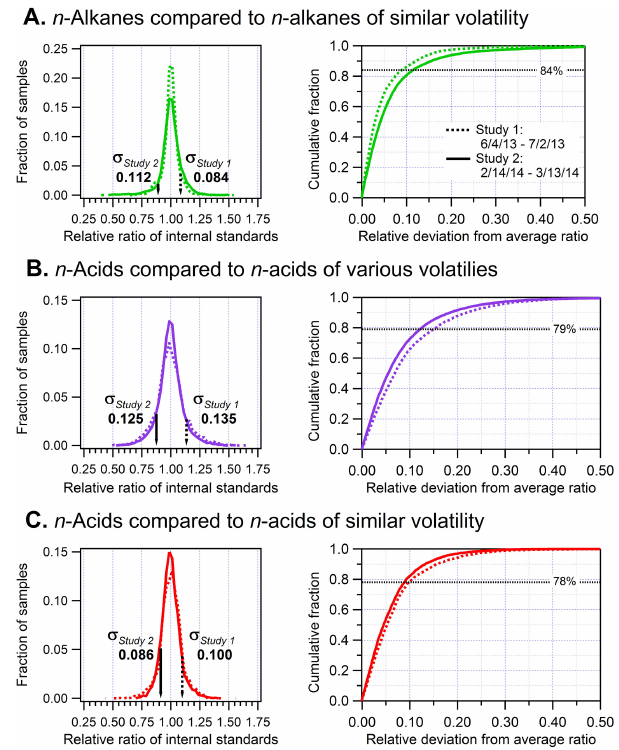
Figure 4. The ratio of two internal standards relative to their av- erage ratio, with relative standard deviations shown. Distributions of error from two periods of field data collection (dashed: Study 1; solid: Study 2) are shown for scenarios most closely representing operating conditions of TAG: (a) correction of alkanes using alka- nes with similar volatilities to quantify precision in hydrocarbon measurement, (b) correction of alkanoic acids using randomly as- signed alkanoic acids to quantify precision in most oxygenate mea- surements, and (c) correction of alkanoic acids using the alkanoic acid closest in volatility to quantify precision in analytes for which a very similar internal standard is present. In all cases, approximately 80% of all samples fall within the standard deviation of the average (exact percentage in each scenario shown as dotted